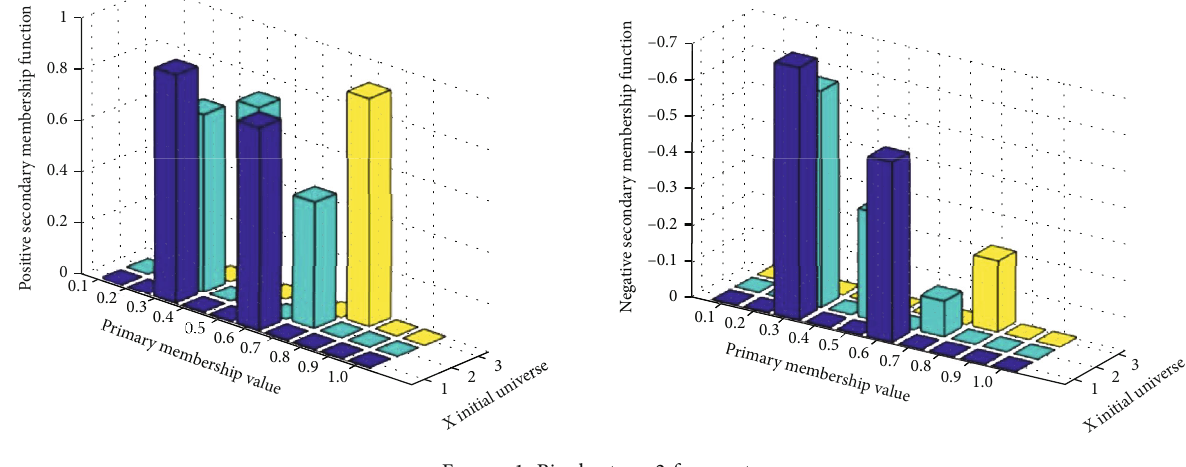
Figure 1: Bipolar type-2 fuzzy